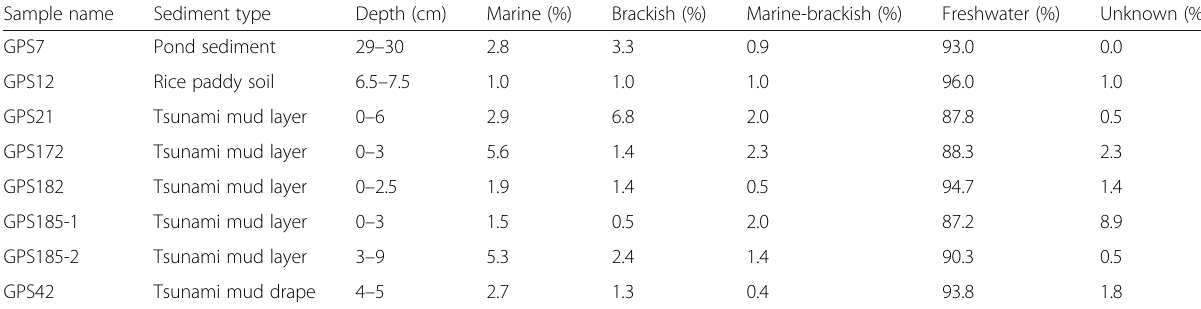
Table 2 Diatom assemblage analysis